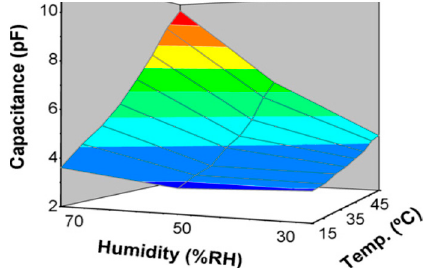
Figure 21. Capacitance of cellulose-PPy nanocomposite sensor (CP-16) as a function of temperature and humidity [150].